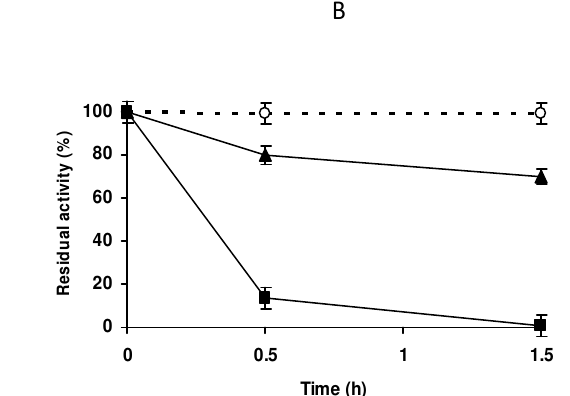
Figure 3. Effect of the pH value in the immobilization courses of PGA on agarose-MANAE-VS at 25 °C in 5 mM of the indicated buffer. Data are shown as residual activity in %, considering 100% the initial activity. ( A ) Sodium phosphate at pH 7.0, and ( B ) sodium carbonate at pH 9.0. Empty circles with dashed line: reference suspension (0.25 mg/mL). Full triangles with solid line: suspension. Full squares with solid line: supernatant. Other specifications are described in the Methods Section.